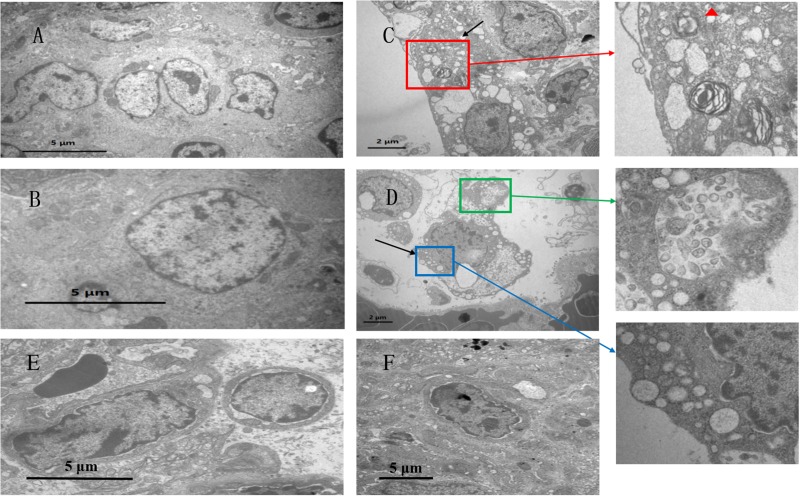
Ultrastuctural analysis showing the effects of co-infection on chicken lung. Transmission electron microscopy of (A,B) control group, at a magnification of 8,000×. Panel (C,D) belong to the co-infection group, at a magnification of 15,000×. (C) Red frame shows that alveolar type II cells are damaged, indicating cytoplasmic vacuolar degeneration. Red triangle shows that eosinophilic lamellar bodies are empty. (D) Blue frame shows that Clara cells have severe vacuolization. Green frame shows that Clara particles are small, and the structure is ambiguous. In addition, Clara particles have low electron density. (E) The MG group shows minor vasotec in alveoid type I cells. (F) In the E. coli group, the nucleus is separated from the substrate membrane, and the distribution of nuclear kernels is abnormal.